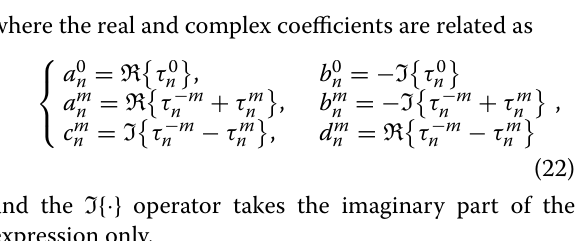
2015); Chulliat et al. (2016) and are realistic at low